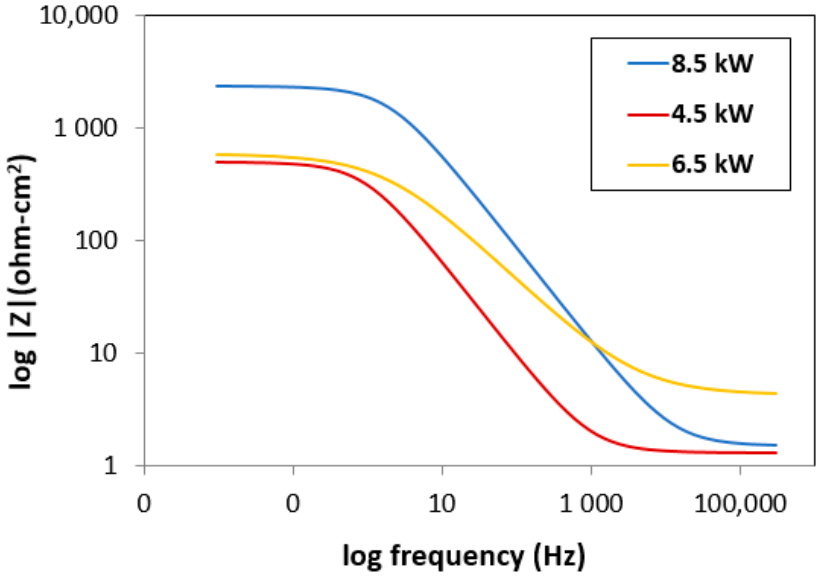
Figure 6. Bode magnitude plot of 2205 duplex stainless steel in 3.5% NaCl solution.